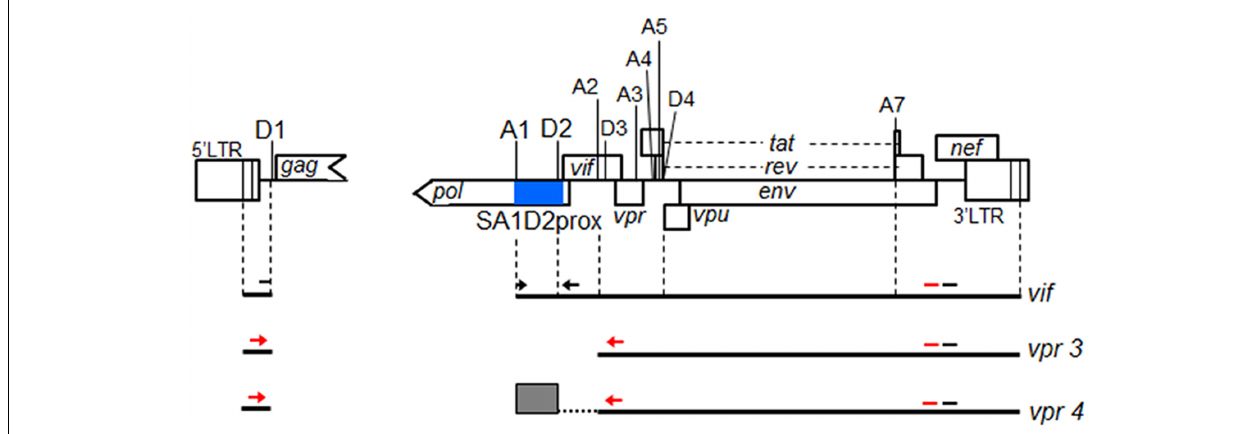
FIGURE 1 | Schematic representation of HIV-1 NL4-3 genome. Various splicing donor (SD) and splicing acceptor (SA) sites in HIV-1 genome are indicated. SA4b, a, c sites are omitted. A blue box indicates SA1D2prox. Black lines represent 4 kb mRNAs of vif and vpr , and exon2 generated by splicing at SA1 and SD2 is indicated by a gray box. Black arrows and black bars represent amplified regions by qRT-PCR of vif mRNA and all HIV-1 mRNAs, respectively. Regions amplified by semiquantitative PCR to analyze vpr mRNAs and all HIV-1 mRNAs are shown by red arrows and red bars,